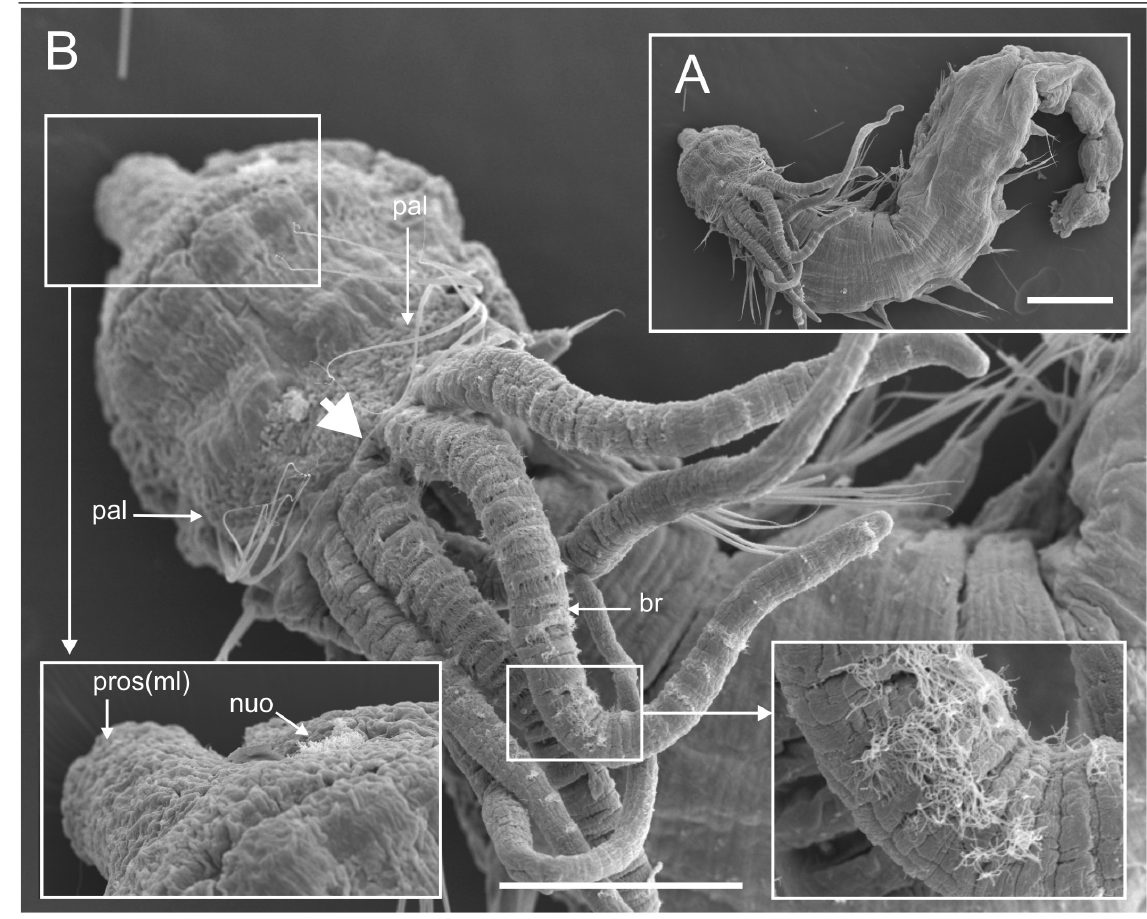
Fig. 4. Ampharete oculicirrata sp. nov., paratype MNCN 16.01/18482_spec. 2. A . Incomplete specimen, dorsal view. B . Anterior end, dorsal view and detail of prostomium and nuchal organ; large arrow pointing to gap between groups of branchiae; framed enlarged areas: prostomium (bottom left) and branchial ciliation (bottom right). Abbreviations: br = branchia; nuo = nuchal organ; pal = paleae; pros(ml) = prostomium (median lobe). Scale bars = 200